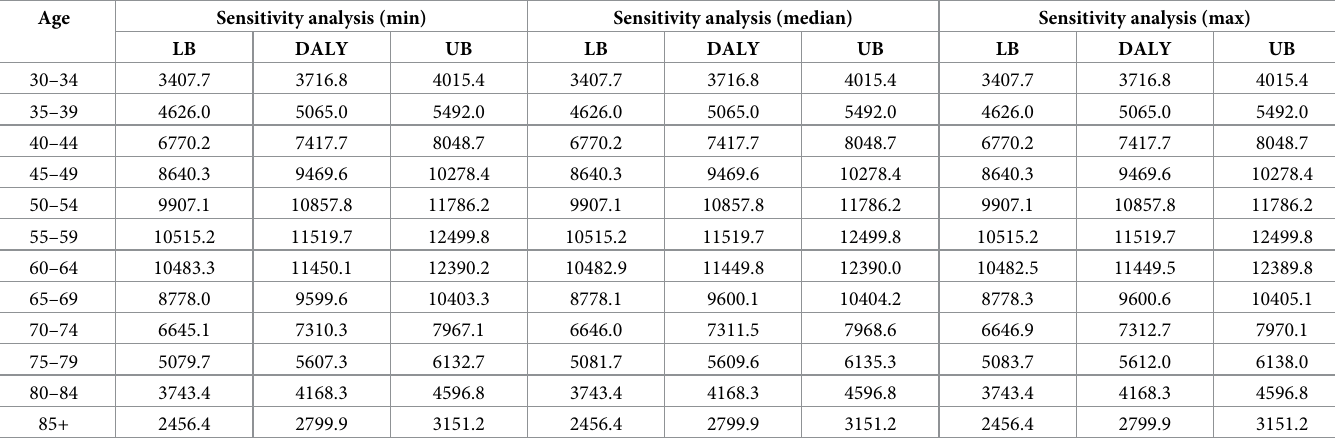
Table 3. Results of sensitivity analysis in males.